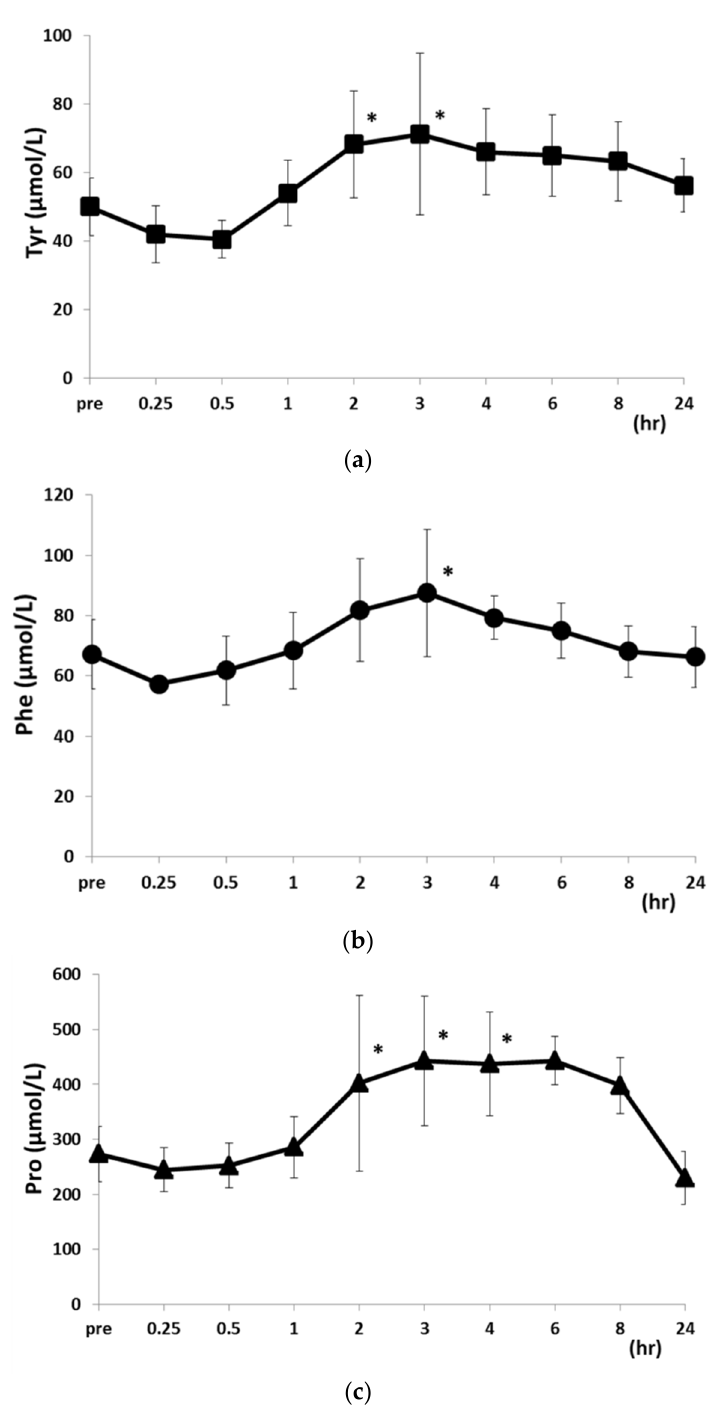
Figure 5. Changes in Tyr ( a ); Phe ( b ) and Pro ( c ) concentrations after food intake. Data are shown as mean ± SD. * p < 0.05 vs. 15 and 30 min post-food intake.